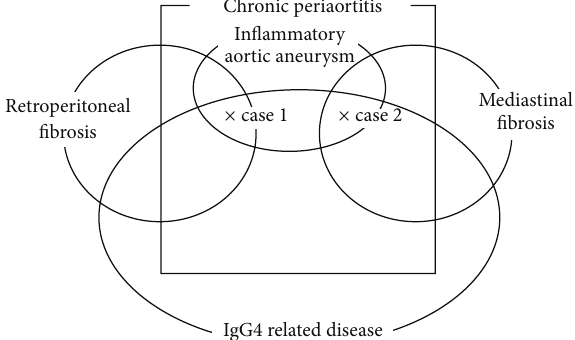
60 mg/day of prednisolone and was gradually tapered off